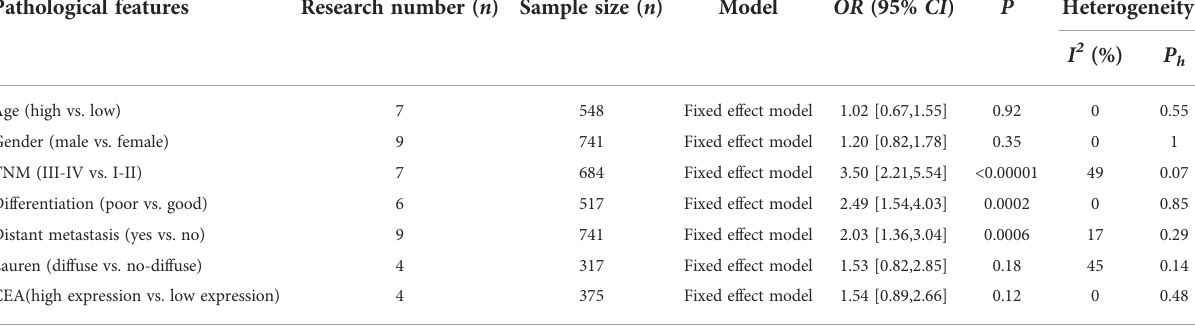
TABLE 3 Relationship between CTC and clinicopathological features of patients with gastric cancer. Pathological